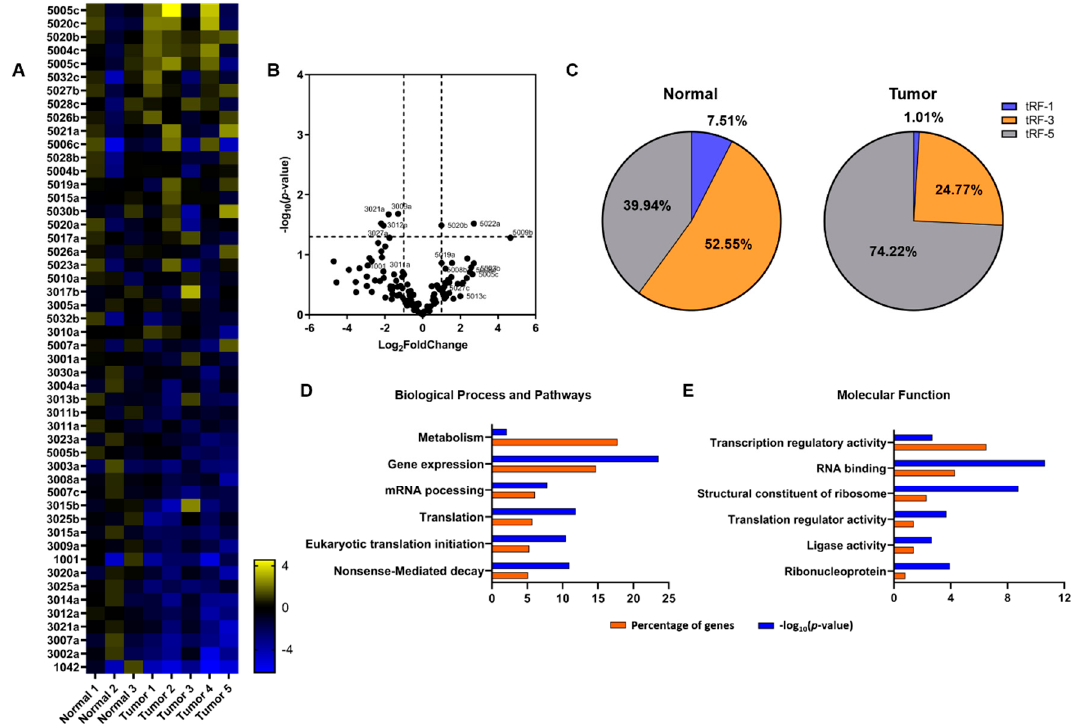
is described in Table S1). The heatmap was constructed based on the log2 fold change values and normal samples are shown after normalization of individual samples versus the mean of RPM. Yellow and blue colors indicate up- and down- regulation, respectively. ( B ) Volcano plot of all miRNAs assessed in the present analysis. The volcano plot displays the relationship between fold change and significance using a scatter plot view. A higher value indicates greater significance in the y-axis and the x-axis illustrates the di ff erence in expression levels of miRNAs. ( C , D ) GO enrichment analysis on the predicted targets of the statistically significant altered miRNAs. Top pathways in “Biological Process and Pathways” and “Molecular Function” are shown as percentage of genes (orange) and p -value Cancers 2020 , 12 , x (blue), respectively.